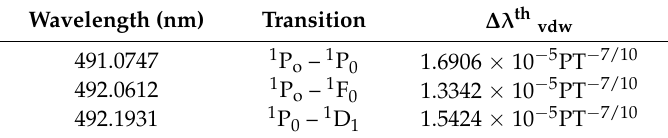
Table 2. van der Waals width formulas for the He I 492.2 nm line in helium plasma.